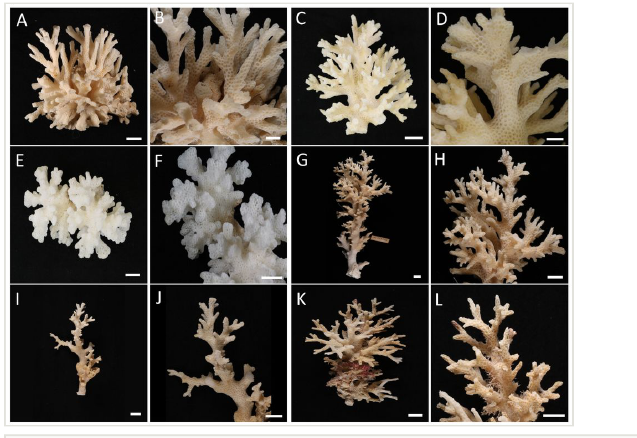
Figure 2. Pocillopora specimens previously identi fi ed as P. damicornis from the Zoological Reference Collection, Lee Kong Chian Natural History Museum, Singapore (A, B: ZRC.1980.20.133; C, D: ZRC.1991.766; E, F: ZRC.1987.1538; G, H: ZRC.1987.1995; I, J: ZRC.1991.763; K, L: ZRC.1987.1537). A–F, colonies with thick branches; G–L, colonies with thinner branches. Scale bars represent 1